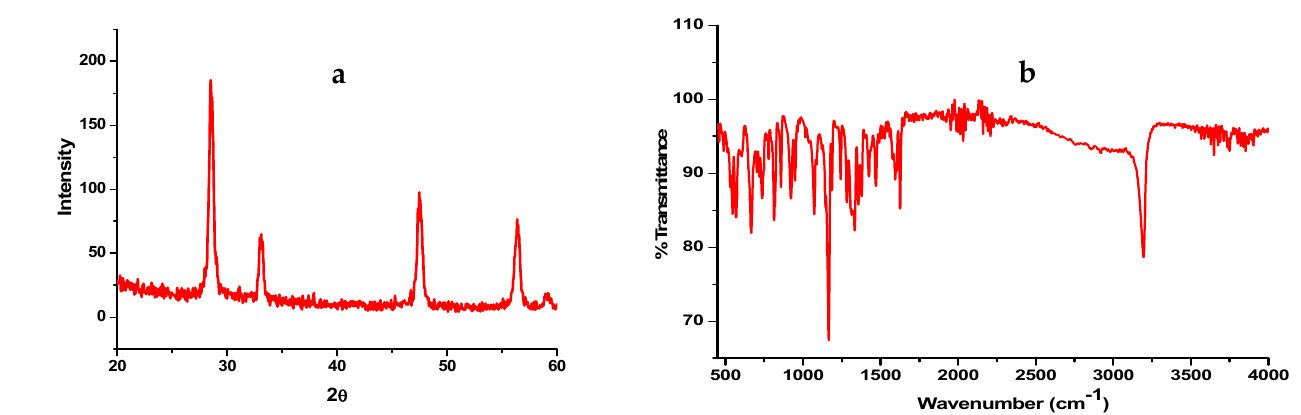
Figure 3. ( a ) X-ray power diffraction (XRPD) pattern and ( b ) FTIR spectrum of CeO 2 -CuO nanocomposite.